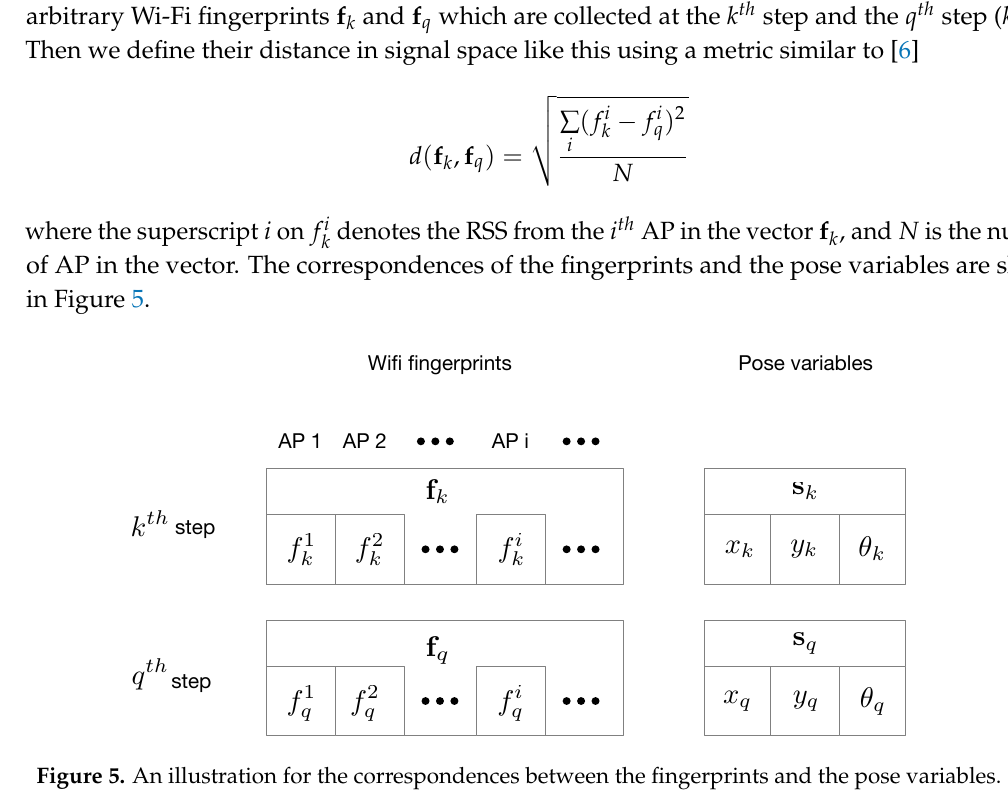
Figure 5. An illustration for the correspondences between the fingerprints and the pose variables.